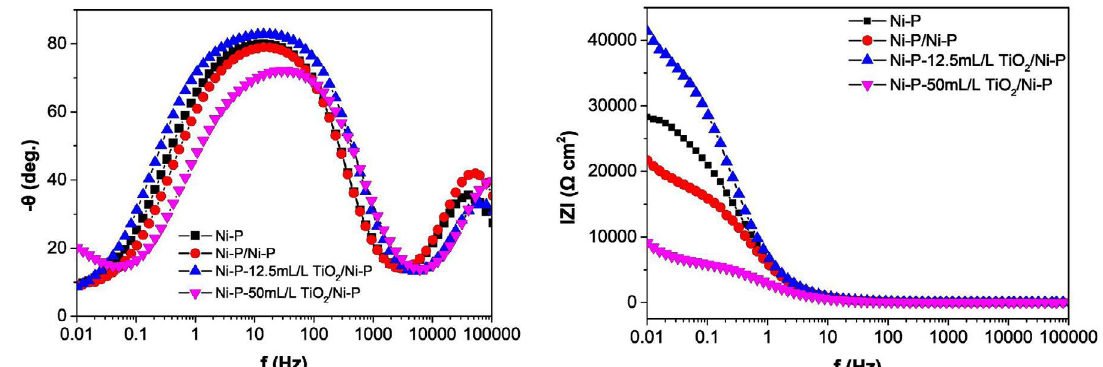
/Ni-P coatings. (a) The relationship between frequency and phase angle; (b) 2